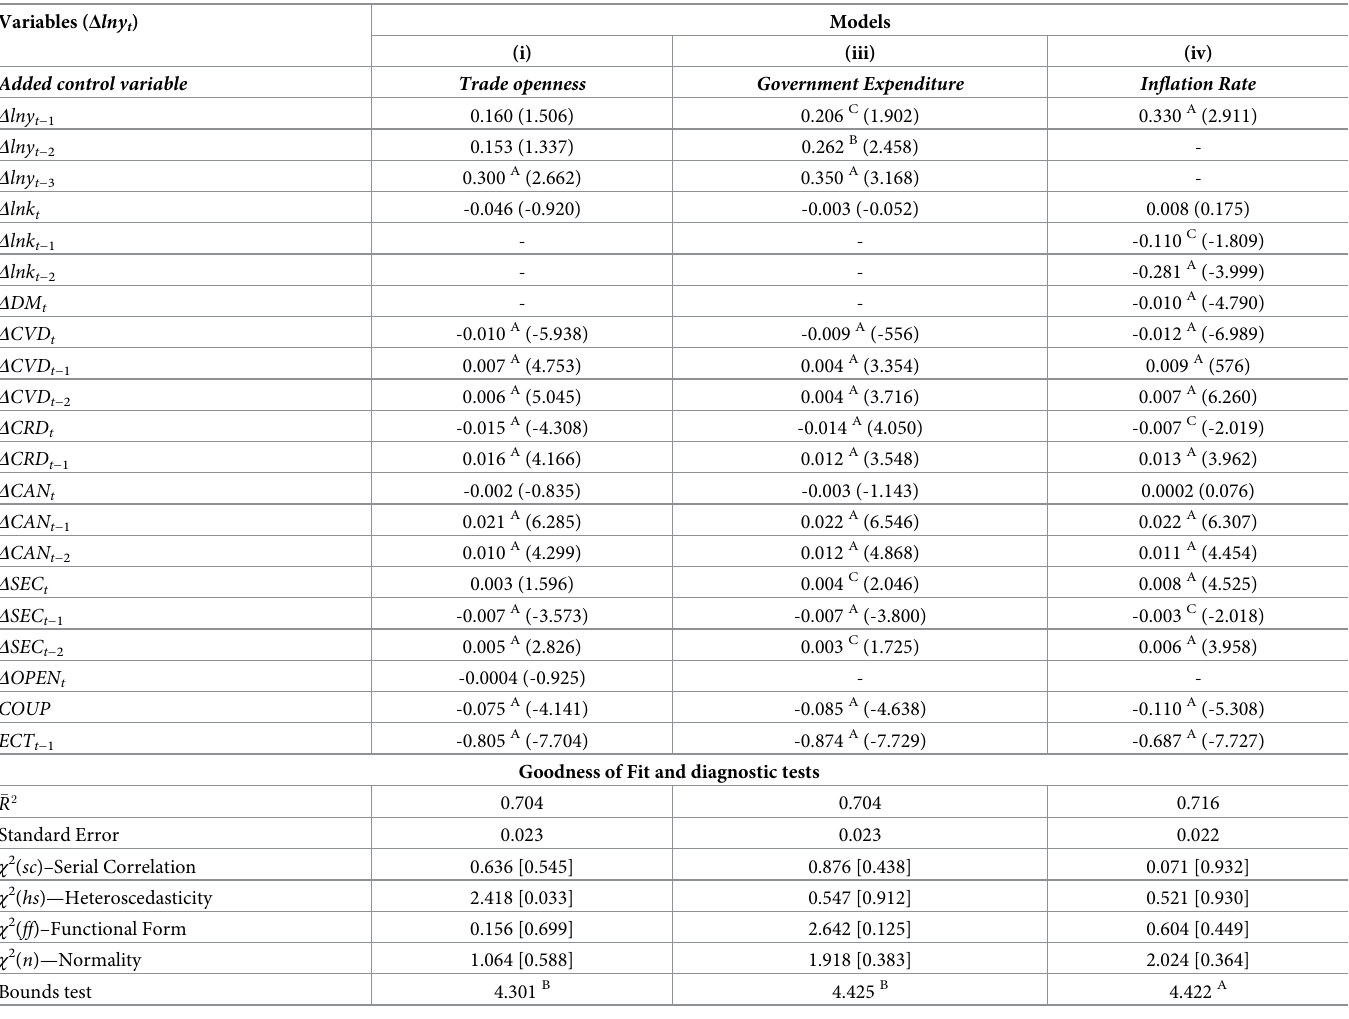
Table 10. Error correction representations for the selected ARDL model–robustness